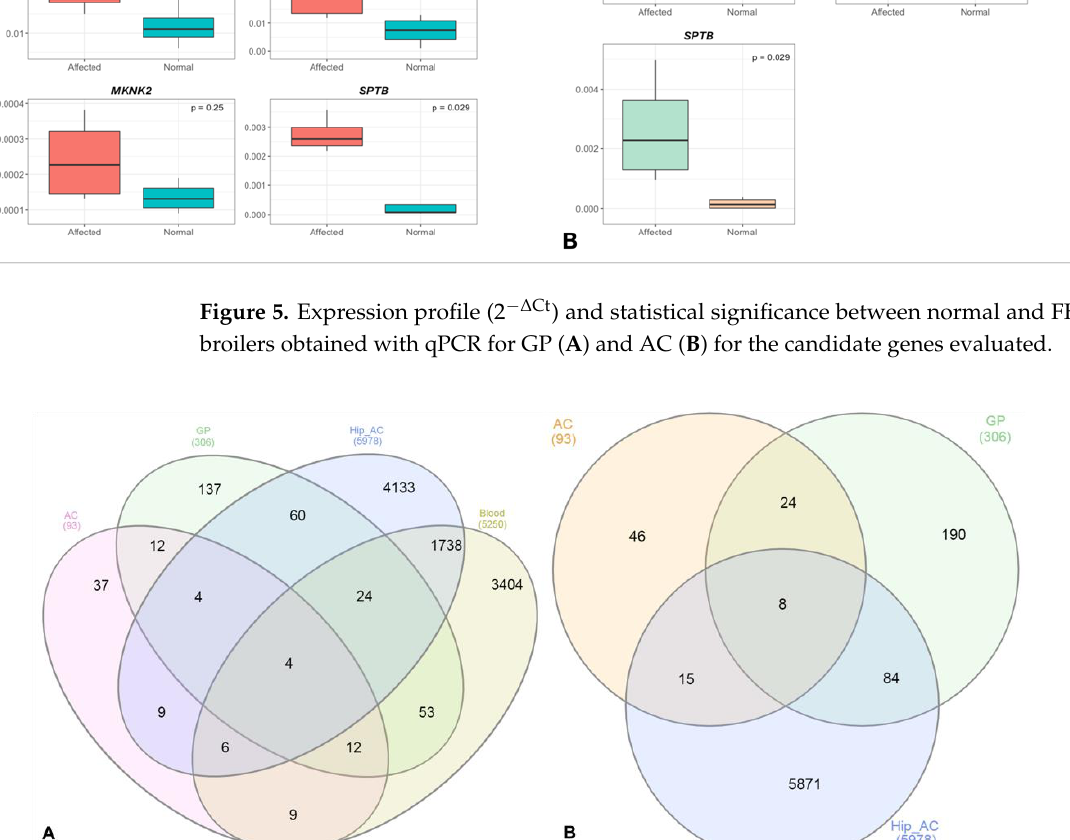
Figure 5. Expression profile (2 −ΔCt ) and statistical significance between normal and FHS-affected